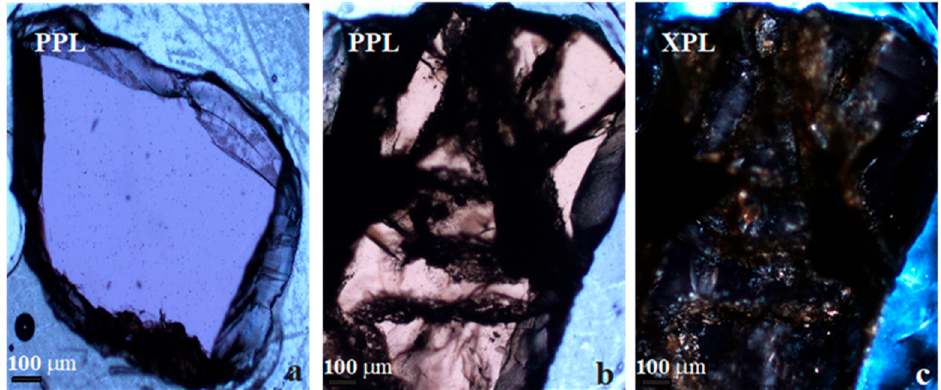
Figure 2. Thin-section images of pyrope: ( a ) plane-polarized light (PPL) image for sample 1, ( b ) PPL with the corresponding cross-polarized light (XPL) image ( c ) for sample 2, which is anisotropic and contains two cubic phases. The scale bars represent 100 µm.